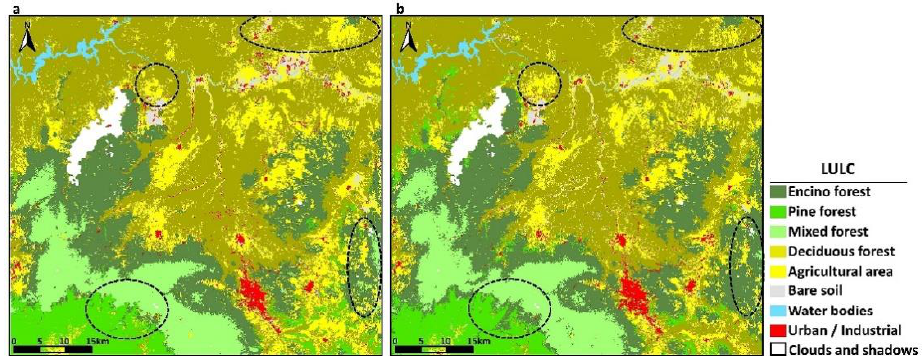
Figure 13. LULC maps from test date (2011), resulting from (a) conventional classification methods and (b) change detection methods. Table 7. Cross tabulation matrix of the LULC maps generated for the test date comparing the applied methods. Values in % about the total area of the LULC categories of the conventional map.